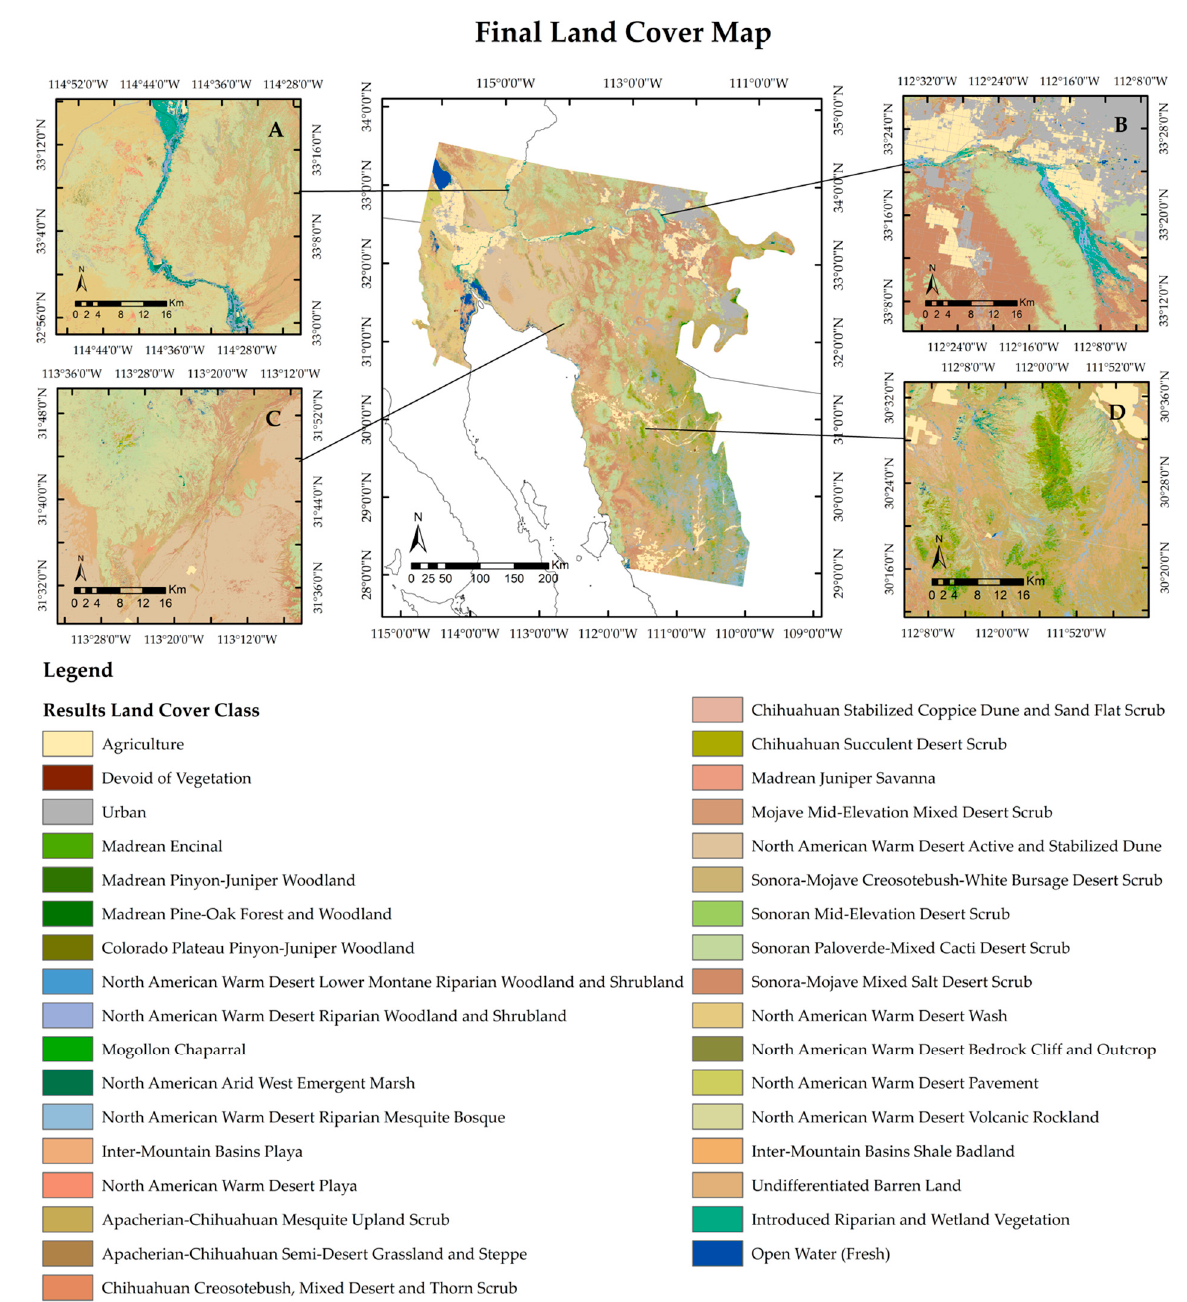
Figure 7. The final transboundary land cover map of the study area classified by the trained RF model. The results shown are classified according to the unified classification system adapted from GAP, which includes agriculture, devoid of vegetation, and urban